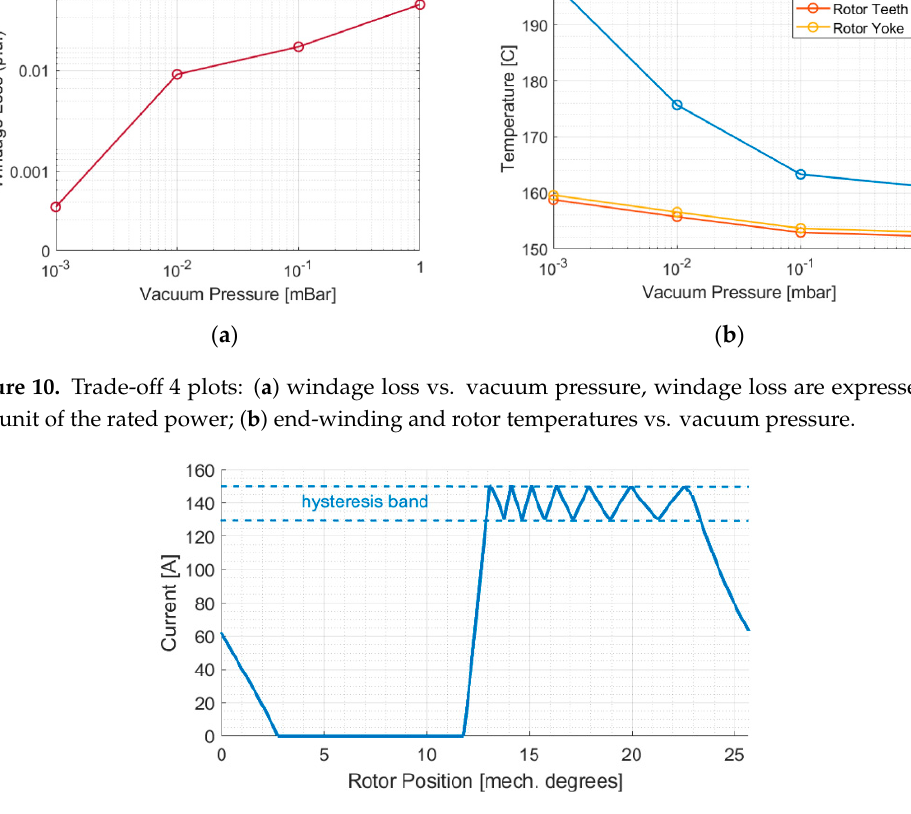
Figure 11. Current waveform at 1120 rpm.